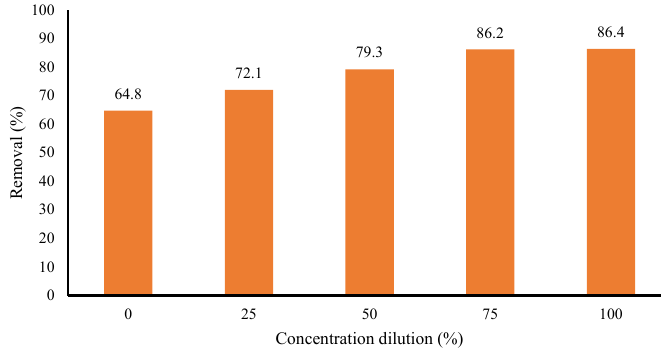
Fig. 6: Influence of bamboo activated carbon for removing nickel from electroplating industry wastewater against the concentration dilution